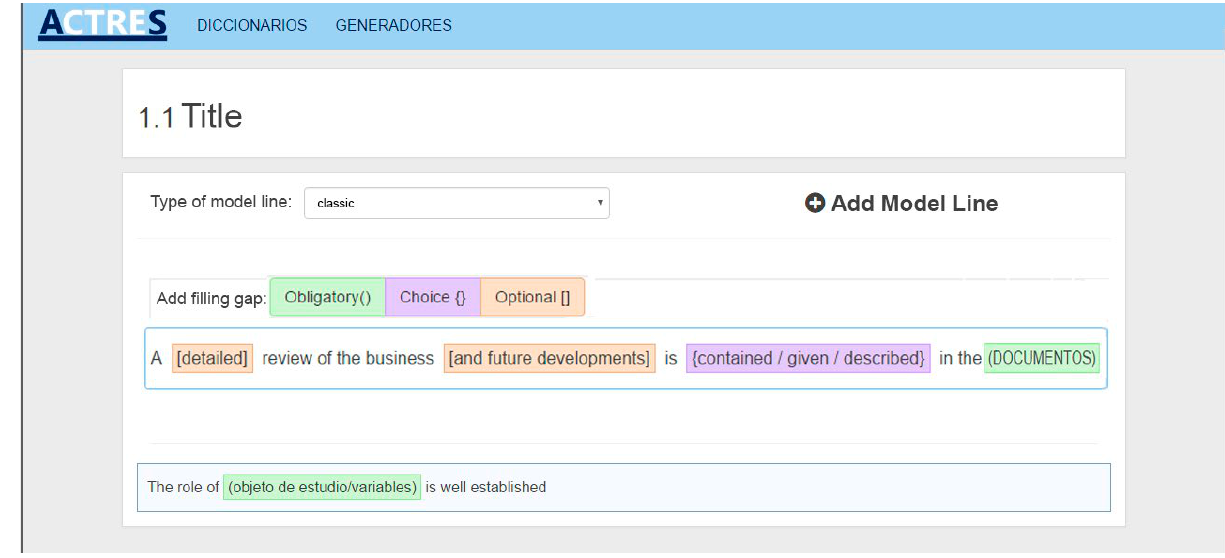
Figure 3. Acquisition Interface